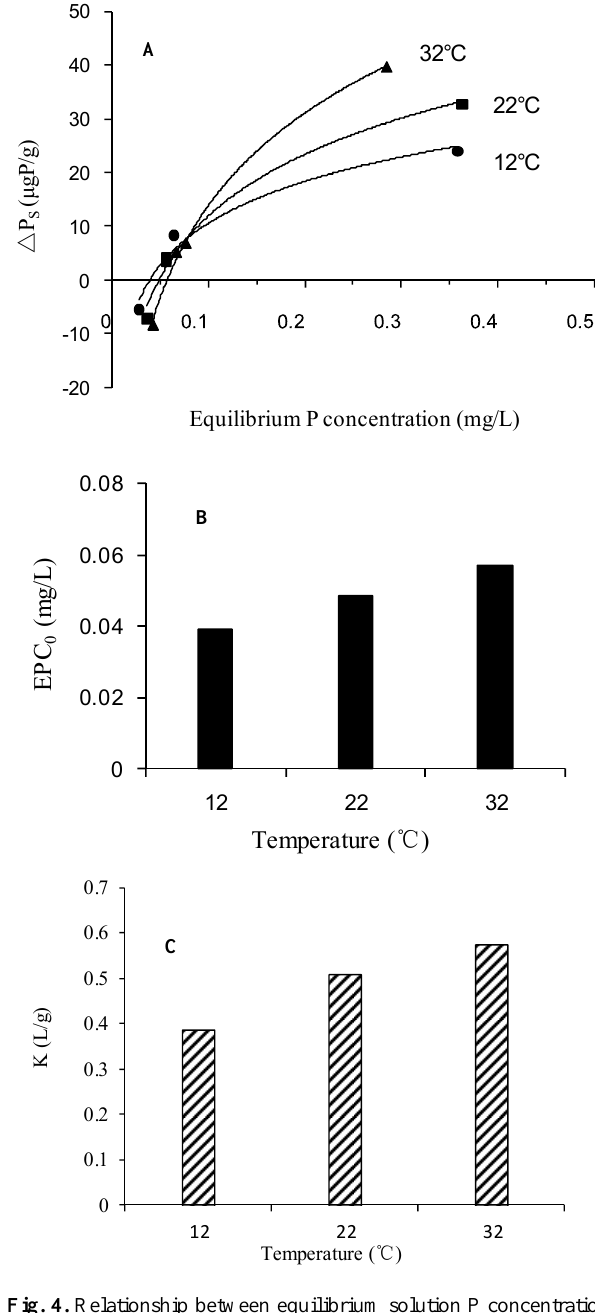
Fig. 4. Relationship between equilibrium solution P concentration Figure 4 Relationship between equilibrium solution P concentration (mg/L) and the amounts of (mgL − 1 ) and the amounts of adsorbed or desorbed P (µg Pg − 1 ) under different temperatures for sediment sample Z4 (a) . Changes adsorbed or desorbed P ( μ g P/g) under different temperatures for sediment sample Z4 (A) . Changes of EPC 0 (b) and K (c) with temperatures for sediment sample of EPC 0 (B) and K (C) with temperatures for sediment sample Z4.